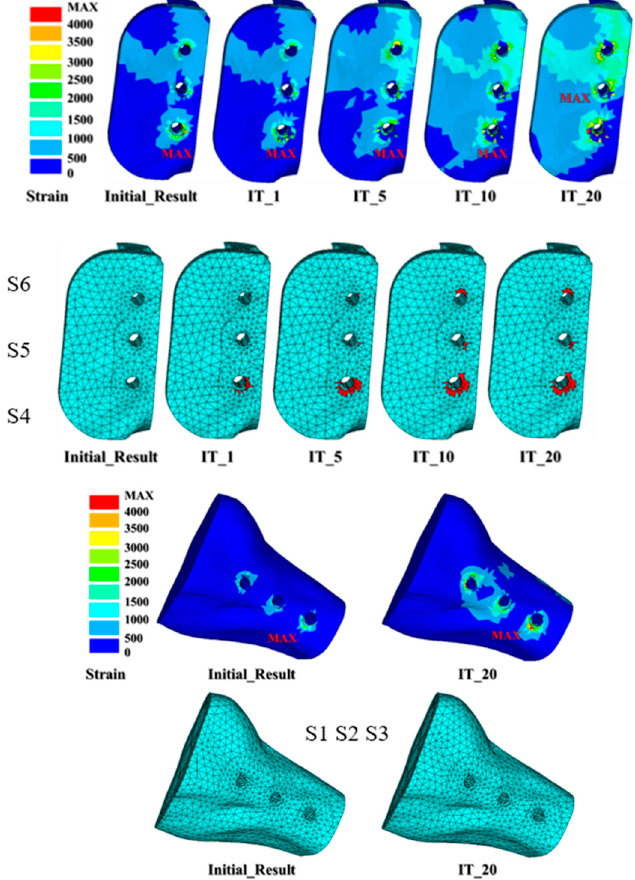
Figure 6. The micro-crack propagation trend, i.e., strain value > 3000 μ at the element around the screw can be represented by the element death number and locations during the iteration analysis process.